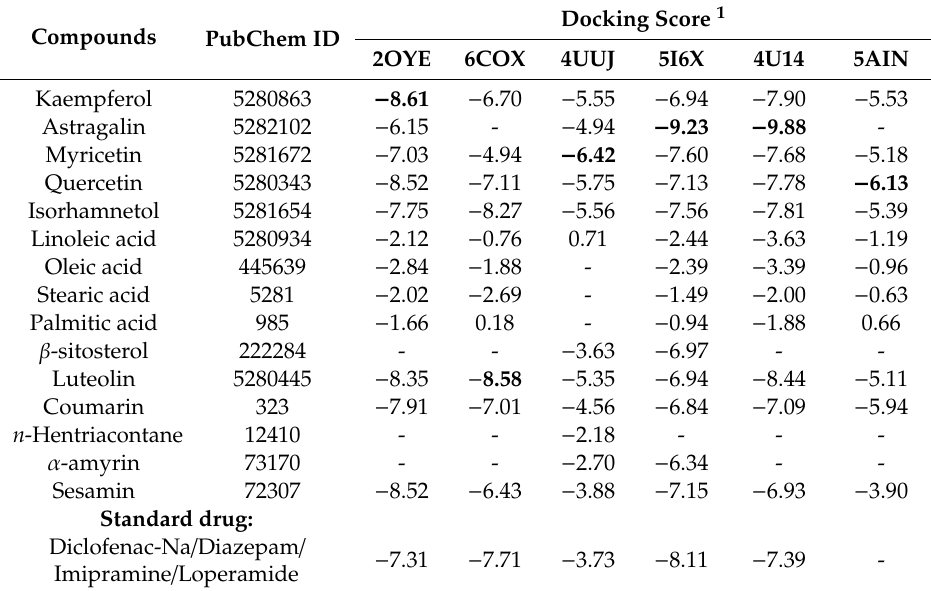
Table 3. Docking score of the selected isolated compounds of Cuscuta reflexa